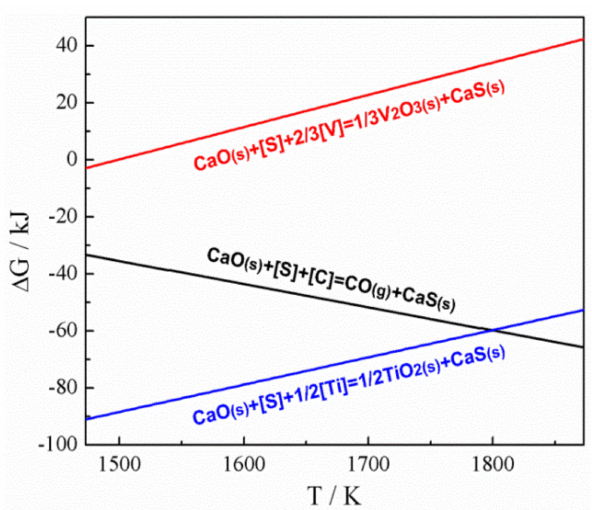
Figure 8. ∆ G values with